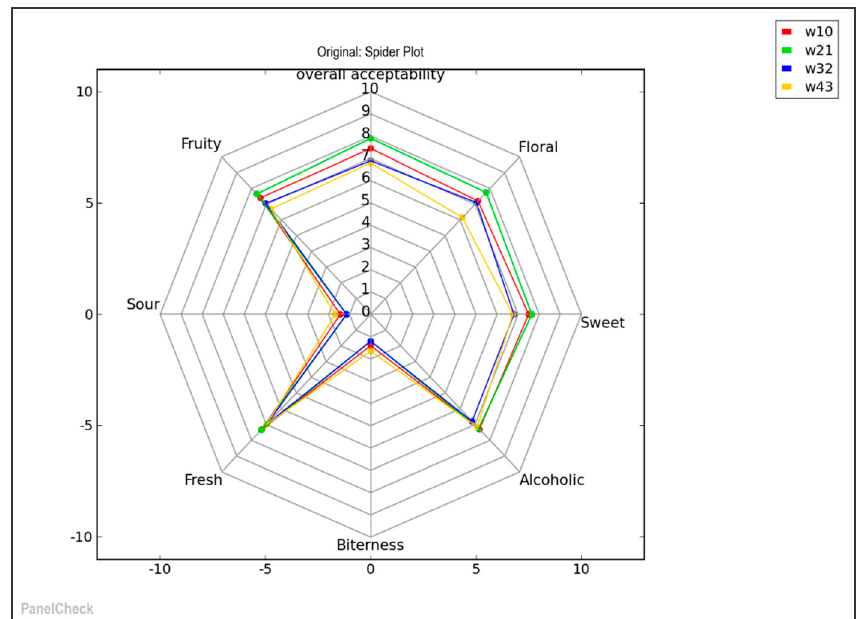
Figure 3. Wines sensory evaluation presented as a spider plot. The research wine samples were prepared by the proposed technology of freeze-dried raw materials without prior storage (W10) and after storage for 30 (W21), 60 (W32) and 90 (W43) days, respectively.